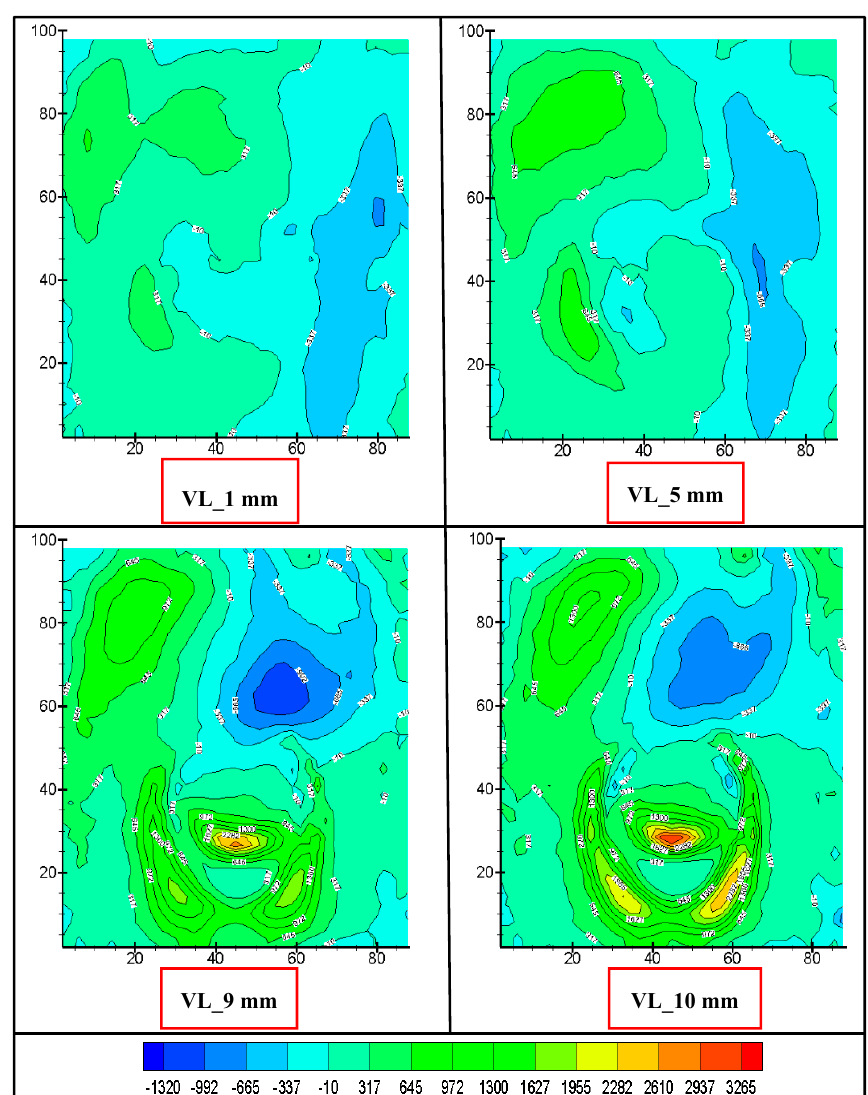
Figure 8. Vorticity magnitudes at different valve lifts.